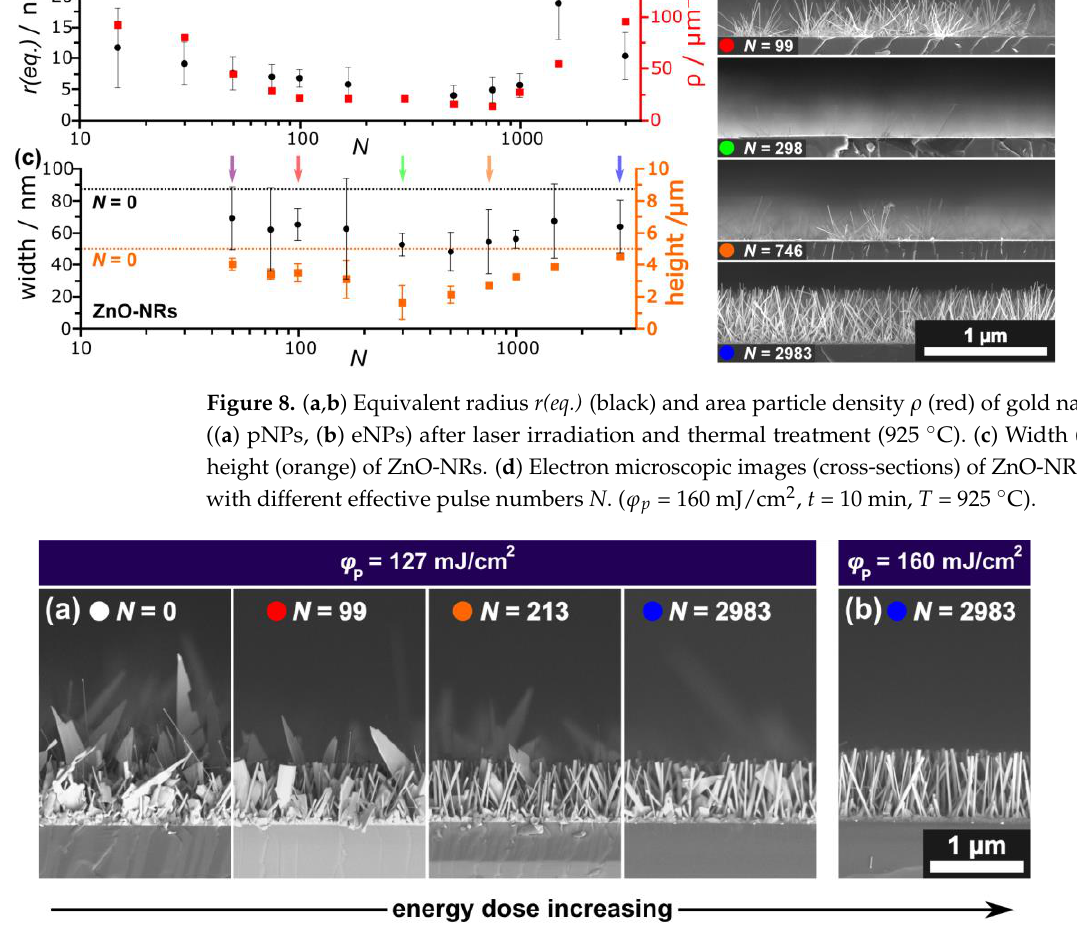
Figure 9. ( a , b ) SEM cross-sections of ZnO-nanostructures (Ar + 1% O 2, t = 10 min, T = 800 °C, ( a ) 𝜑 𝑝 ( a ) ϕ p = 127 mJ/cm 2 , ( b ) ϕ p = 160 mJ/cm 2 ) showing a decrease of VLS-grown nanostructures = 127 mJ/cm 2 , ( b ) 𝜑 𝑝 = 160 mJ/cm 2 ) showing a decrease of VLS-grown nanostructures (nanowires (nanowires and -belts) upon increasing energy and -belts) upon increasing energy dose.